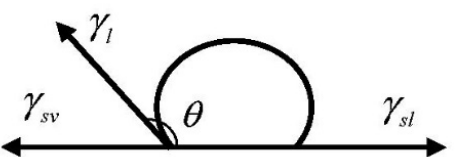
Figure 6. Schematic diagram of interface between the reagent and limestone.